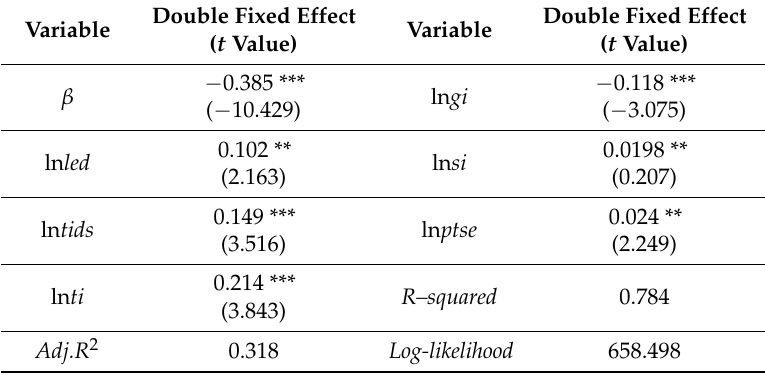
Table 10. Conditional β -convergence SLM model estimation and test